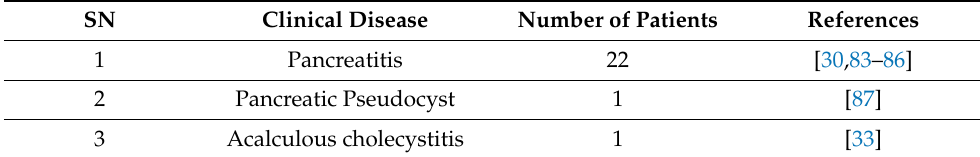
Table 3. Digestive system disorders related to HEV